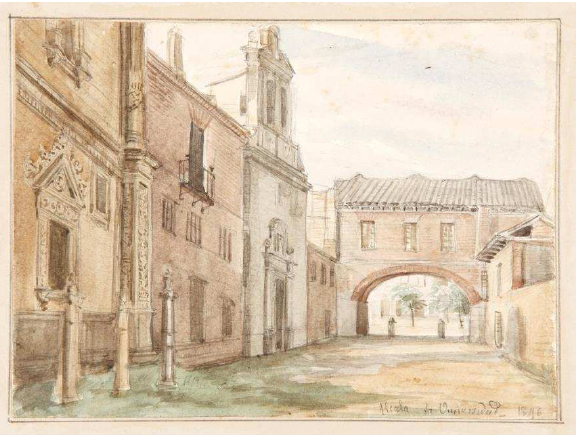
Figure 7: Partial view of the San Ildefonso's residence hall. Engraving 1846. Carderera .